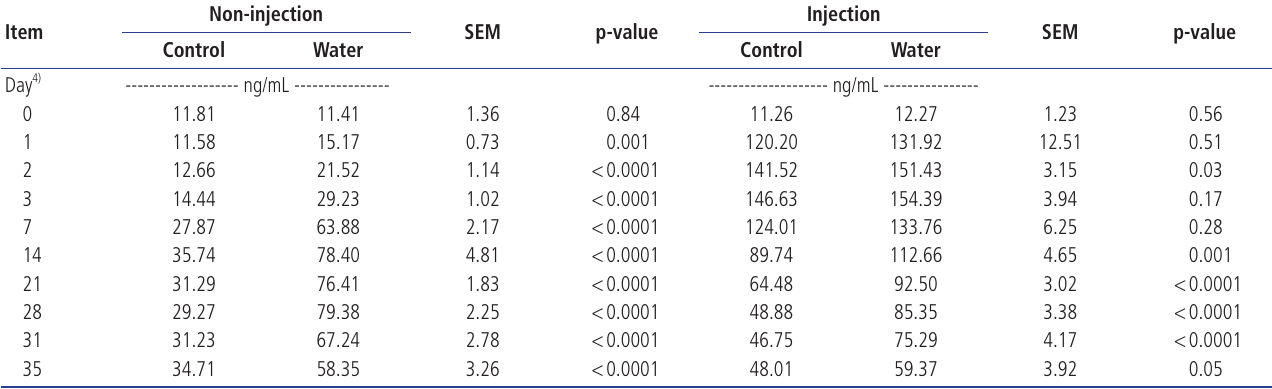
concentration changes of weaning pigs with vitamin D 3 Non-injection SEM p-value